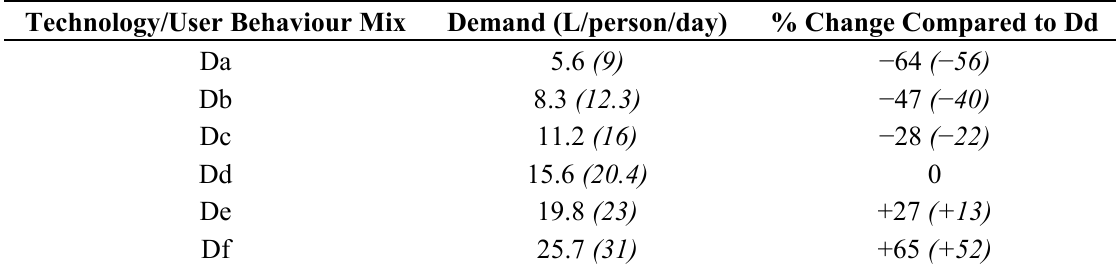
Table 9. Office demands achieved through changes in technology alone: “User behaviour” unchanged ( Italics show where water use by females differs from that of males).